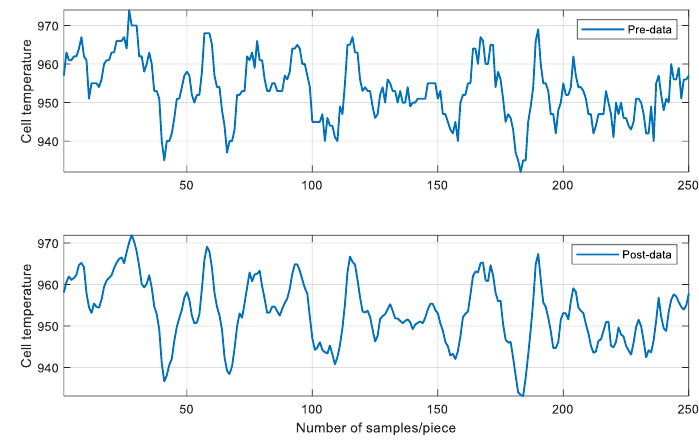
Figure 5. SGFA noise removal.